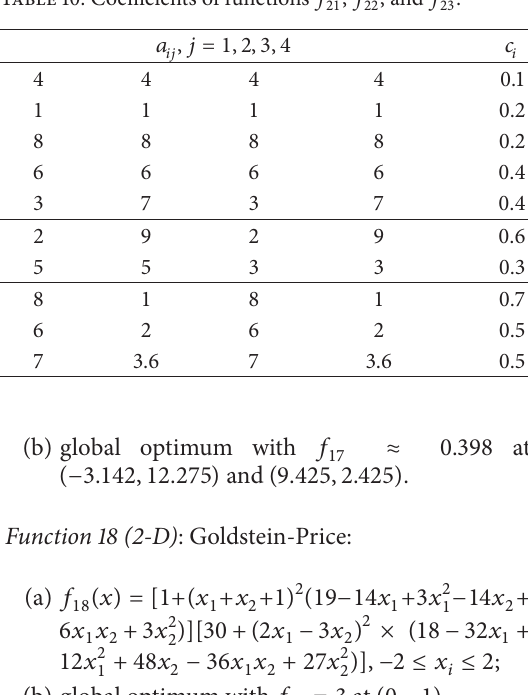
Table 10: Coefficients of functions 𝑓 21 , 𝑓 22 , and 𝑓 23